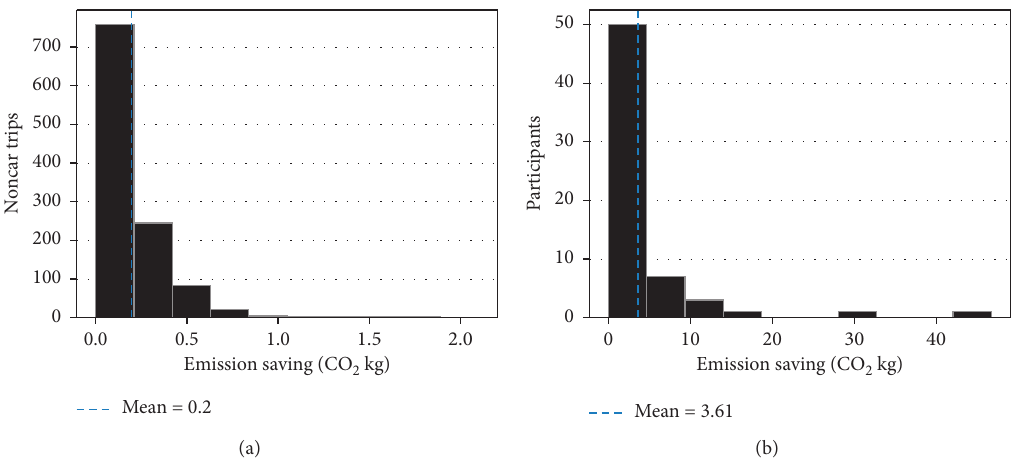
Figure 28: Size of emission savings illustrated per trip as well as per